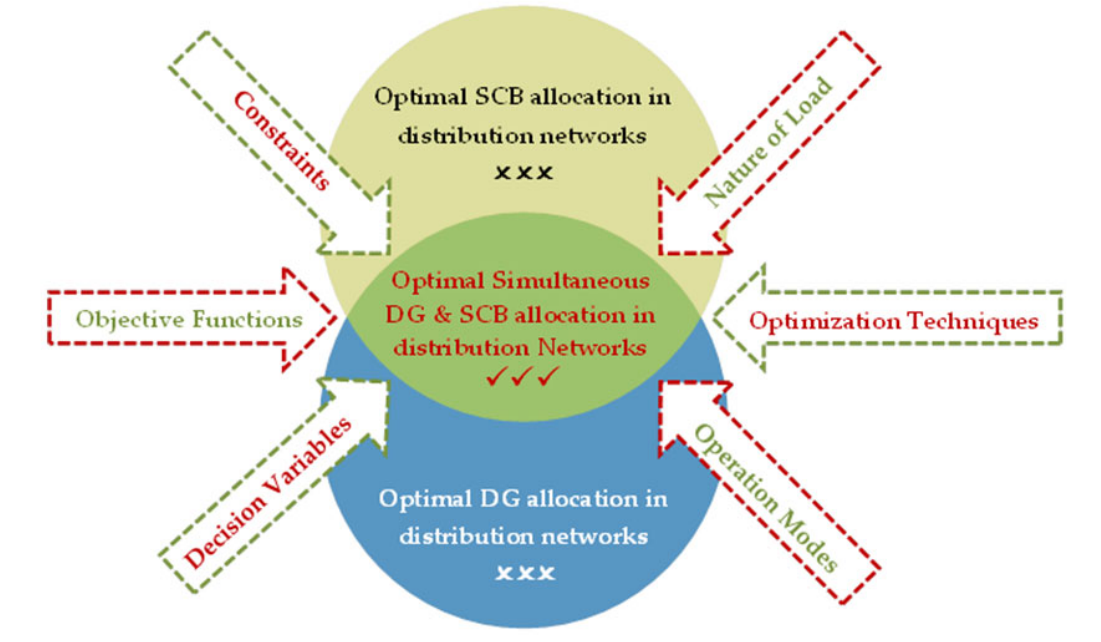
Figure 6. K ey contribution and different aspects reviewed in this article. Figure 6. Key contribution and different aspects reviewed in this